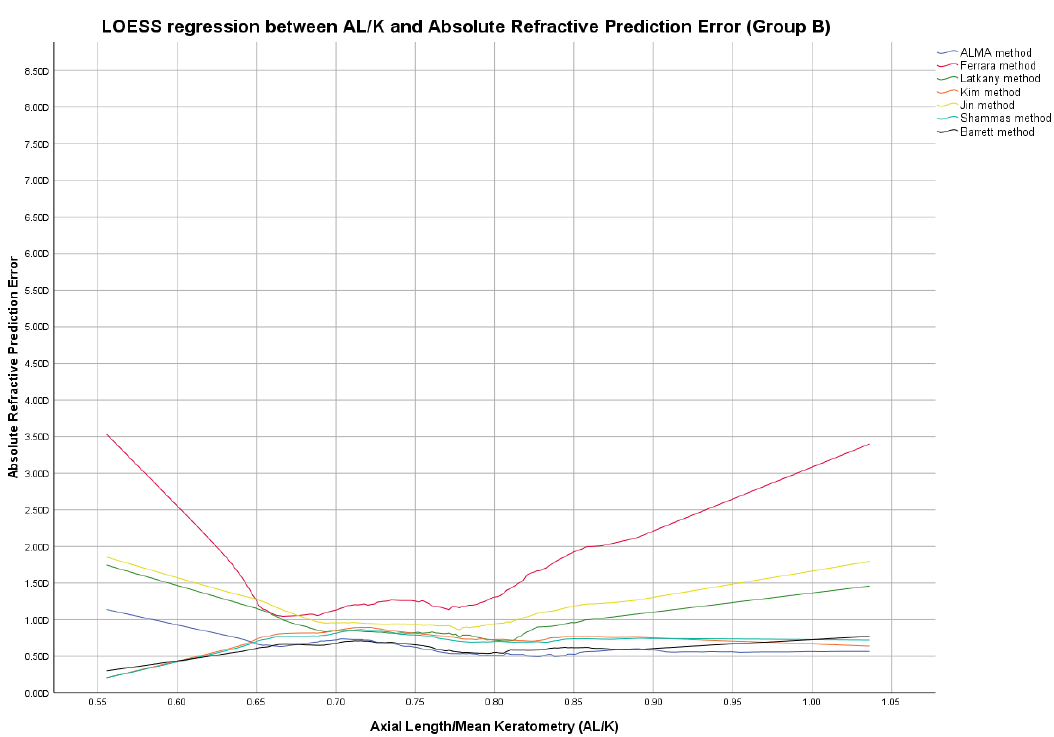
Figure 6. Locally estimated scatterplot smoothing (LOESS) curve between refractive prediction errors generated for each examined formula and the related axial length (AL)/mean keratometry (K) value. (Group B).